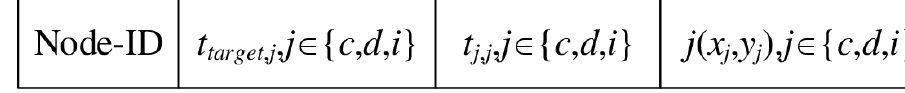
Figure 8. Interaction of location information